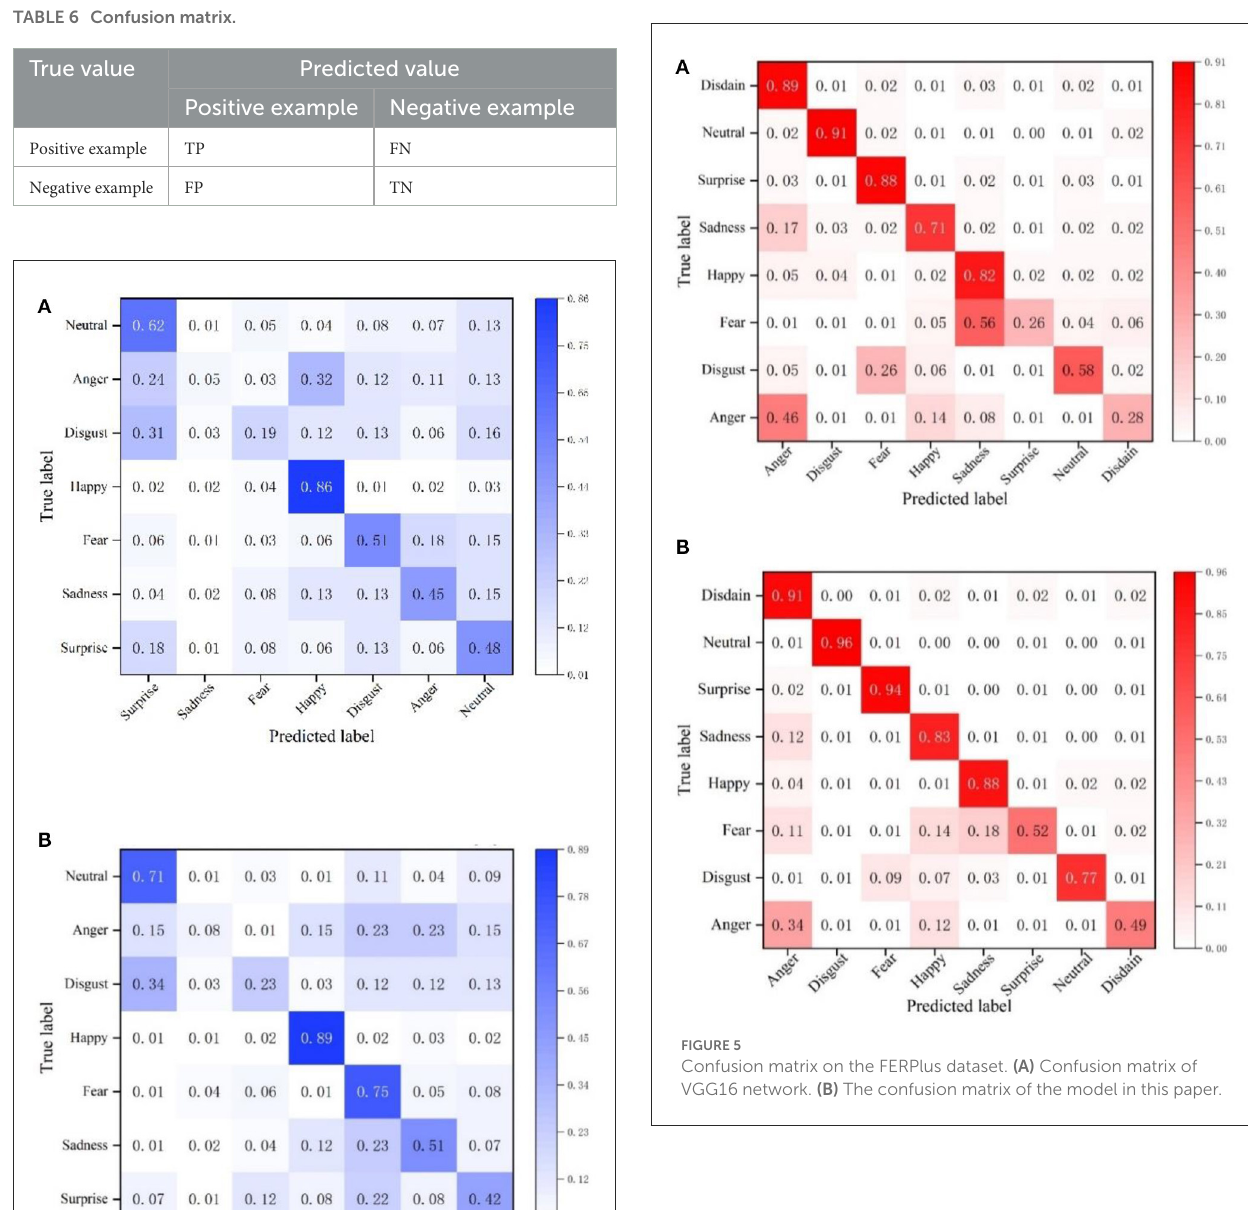
of DLP-CNN, GACNN, PACNN, and LDL-ALSG on the RAF-DB dataset, and the comparison results are shown in Table